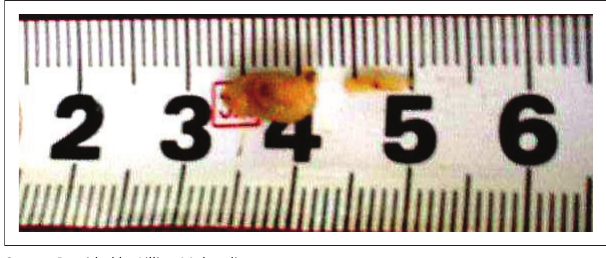
FIGURE 2: Illustration of the different size of 4-day-old larvae from the control farm and the treated farm, from left to right.